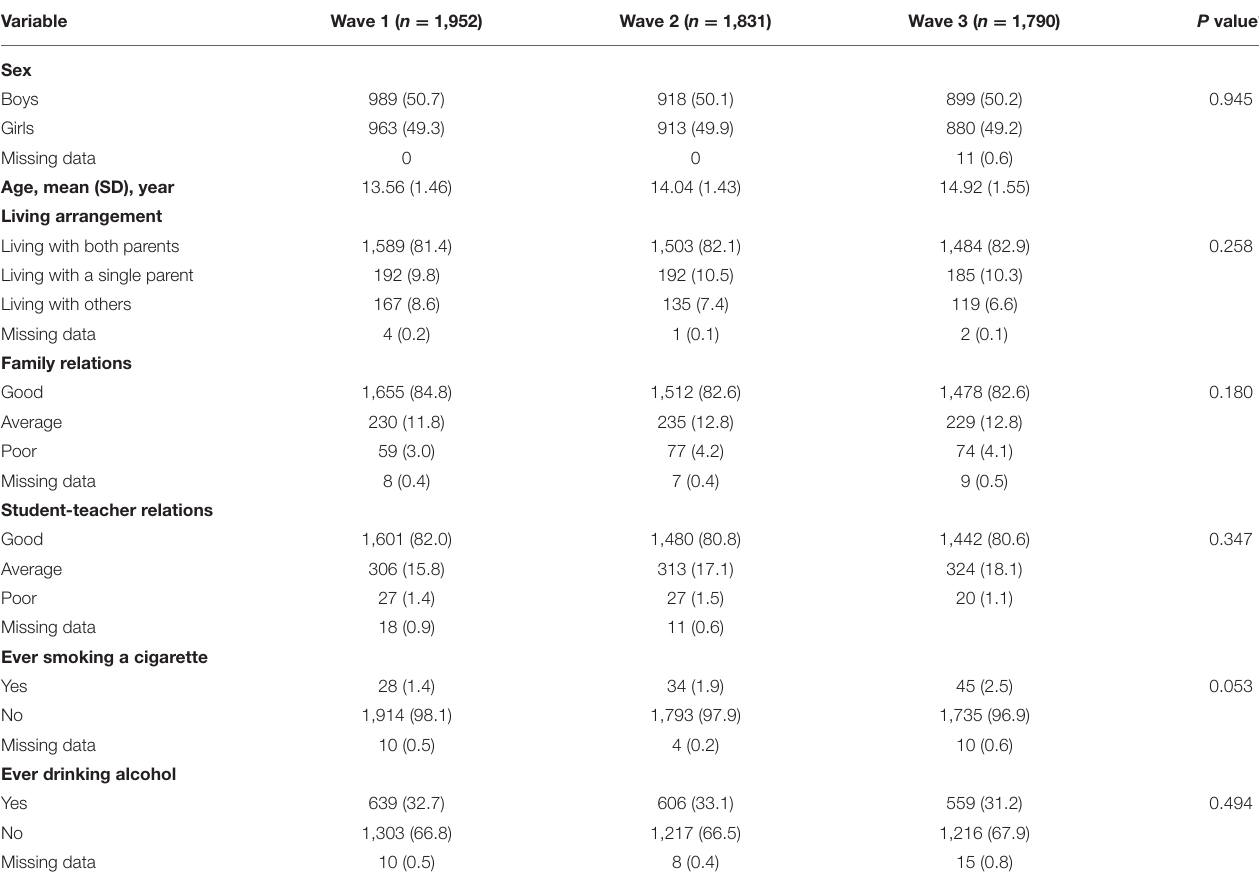
TABLE 1 | Demographic characteristics of the participants across waves for all participants. Variable